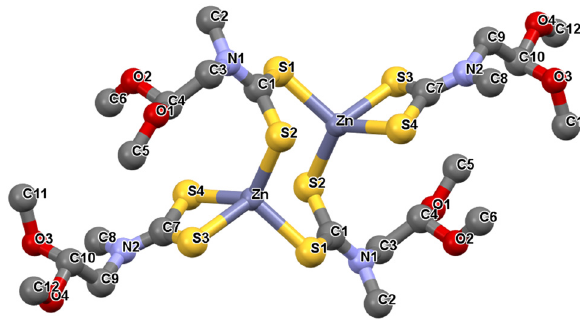
Figure 6: Molecular structure of the centrosymmetric dimer of [ Zn ( S ( OMe ) ) [ 43 ] , with permission 2 CNMeCH 2 CH 2 2 . Redrawn from ref. from Elsevier ( Copyright 2020 )